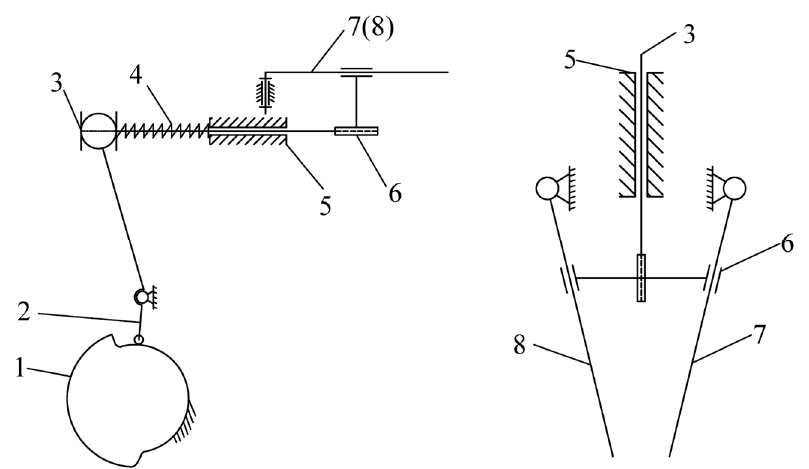
Figure 2. Cam-linkage planetary gear system seedling picking mechanism: 1. Left housing; 2. Plan- etary gear; 3. Intermediate gear; 4. Sun gear; 5. Cam; 6. Linkage mechanism; 7. Roller; 8. Seedling picking arm; 9. Right housing; 10. Rack mounting plate; and 11. Input shaft.